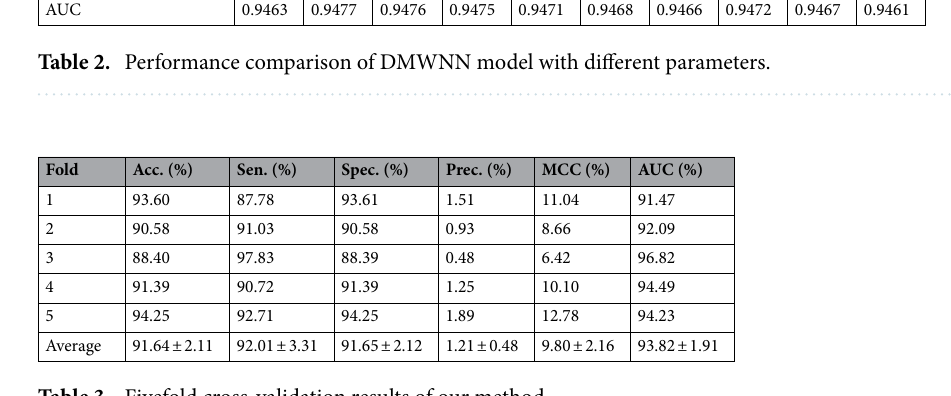
Table 3. Fivefold cross-validation results of our method.